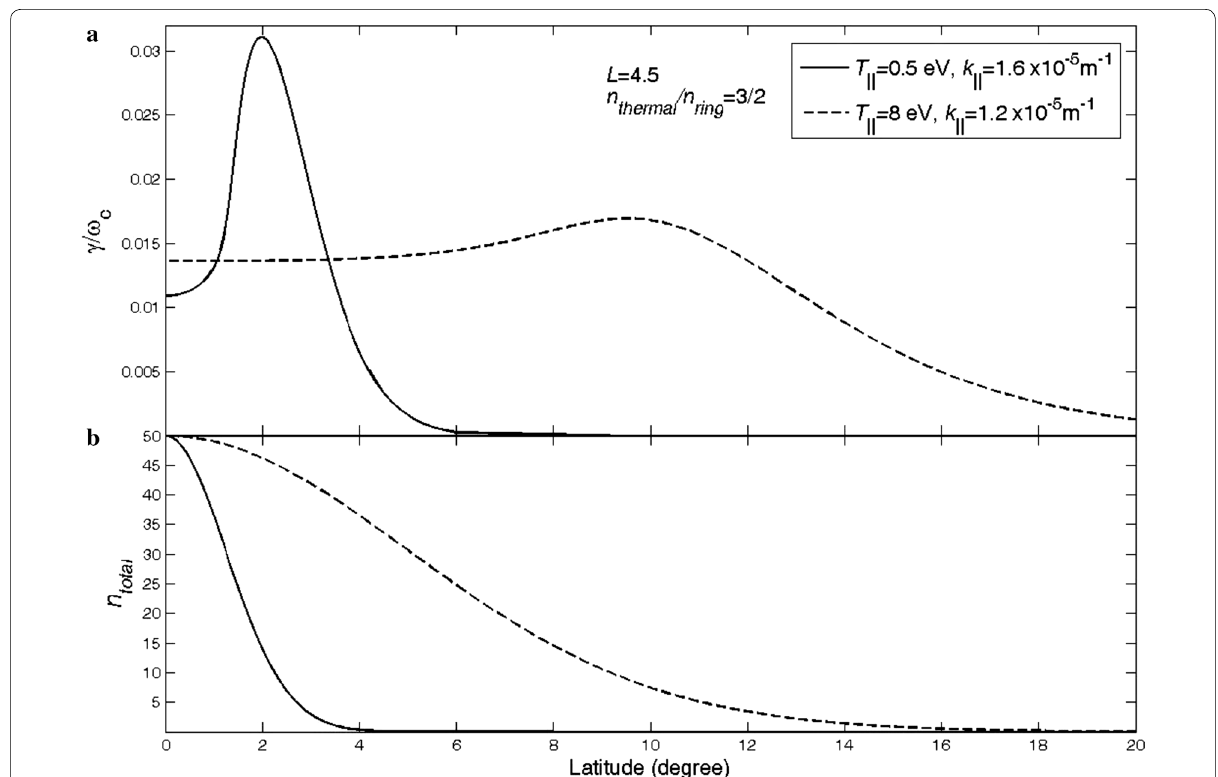
Fig. 12 a The dependence of ICW growth rate on latitude along the L values with these fixed parameters: the equatorial density n eq the density ratio R n